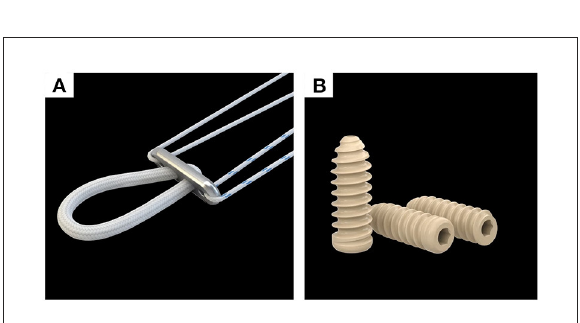
FIGURE2 Endobutton (A) and PEEK interface screw (B) of Delta Medical applied in group